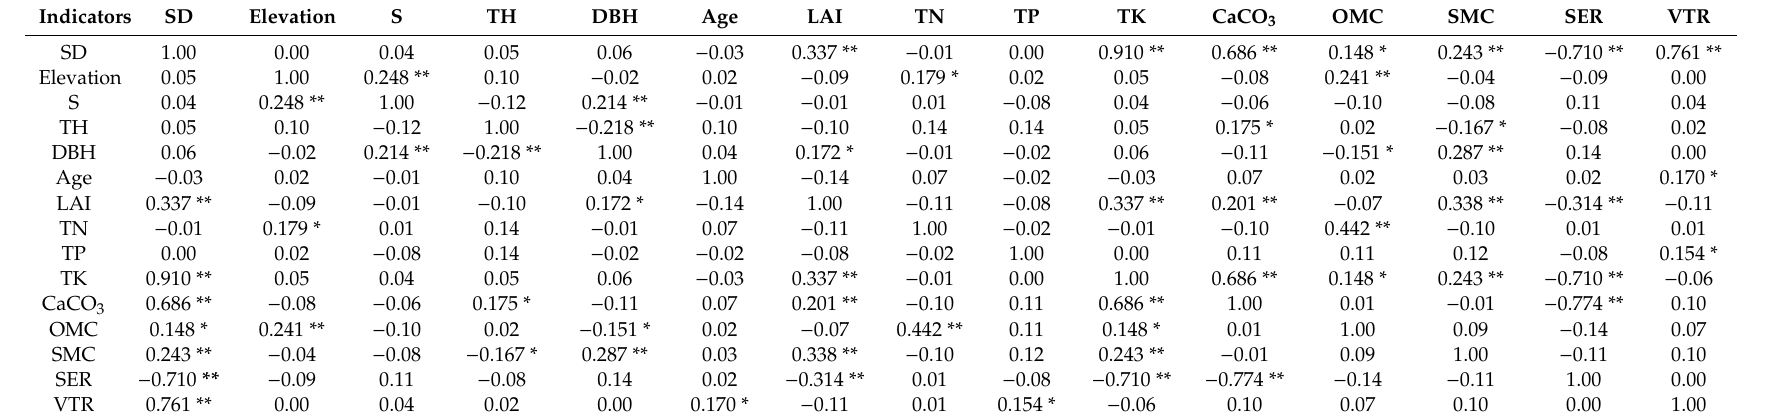
Table 4. Regression analysis of the soil nutrients in R. pseudoacacia